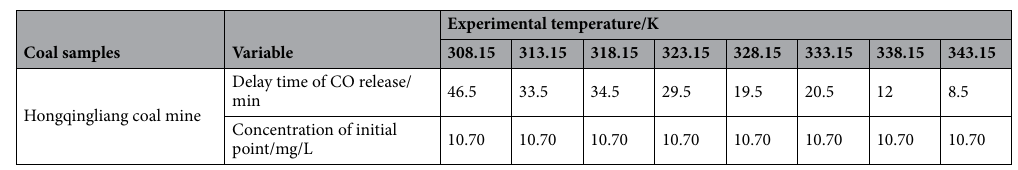
Table 3. Delay time statistics of CO